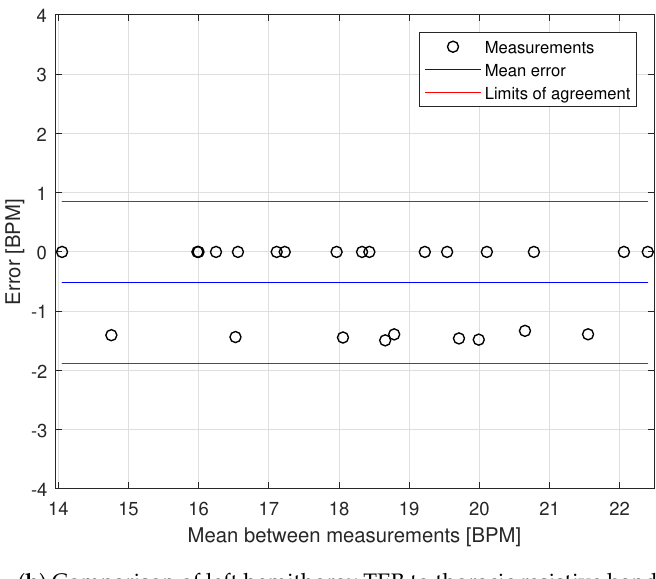
Figure 14. Bland–Altman plots for breaths per minute (BPM) estimation